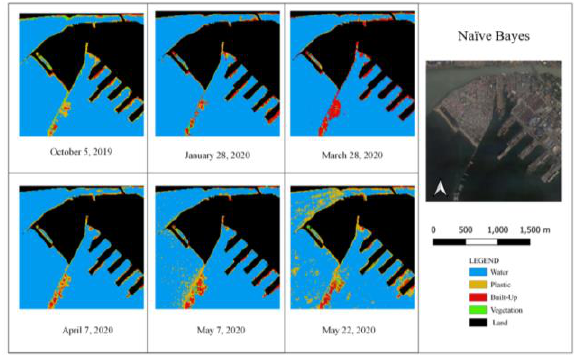
Figure 4 . Resulting classification maps for all satellite images using the Naive Bayes Algorithm.